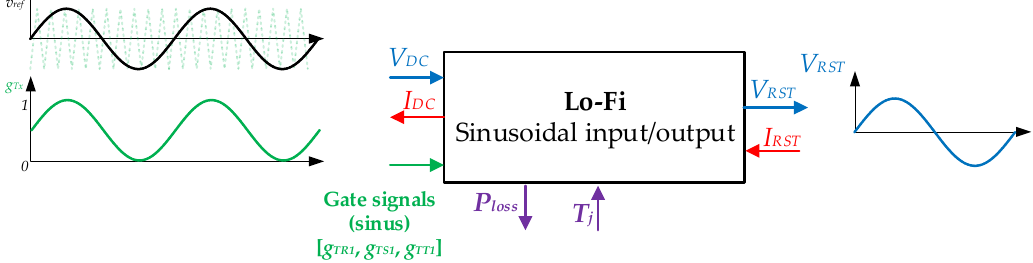
Figure 12. Lo-Fi model block. ( Left ) DC voltage and current, and the gate input low frequency PWM signal. ( Right ) AC voltage and currents. On the lower side, the thermal and power variables are shown.